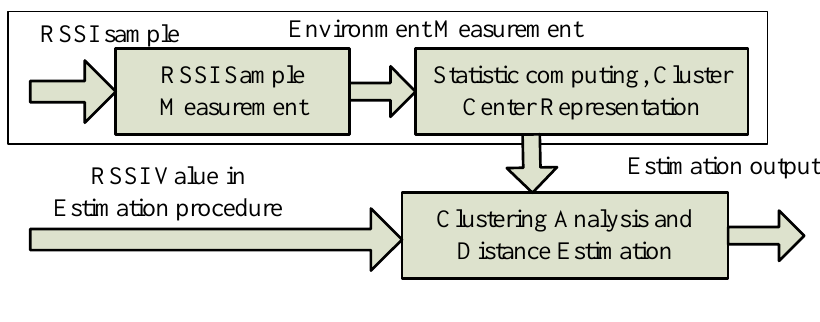
Figure 3. Framework of RSSI-D estimation